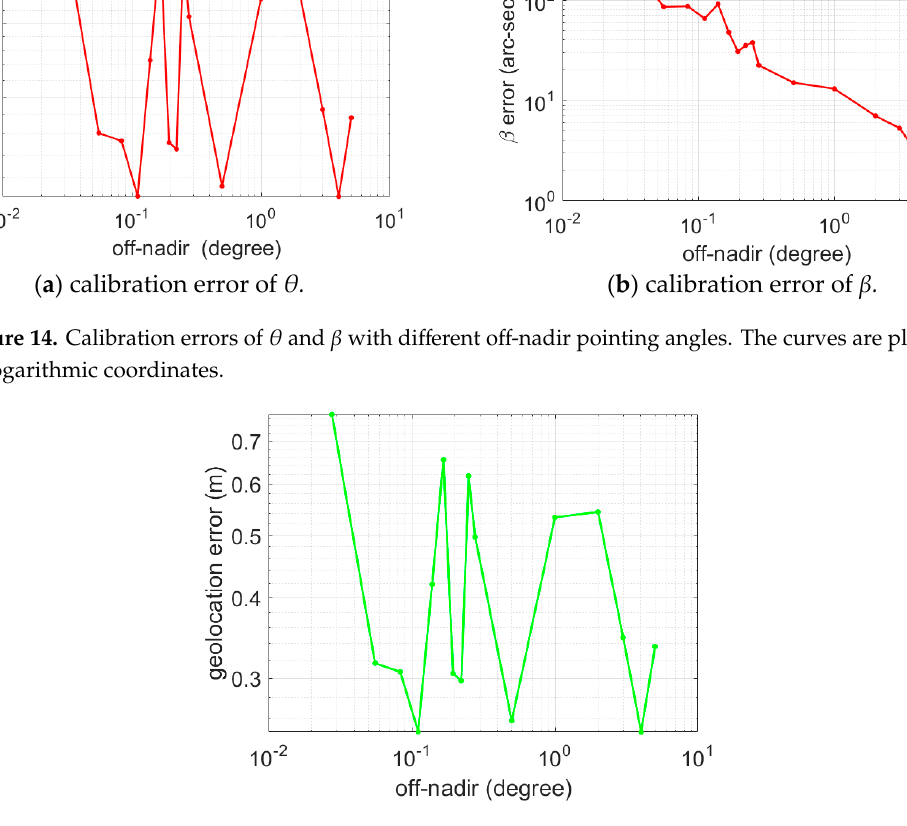
Figure 15. Total geolocation errors after calibration with different off-nadir pointing angles.